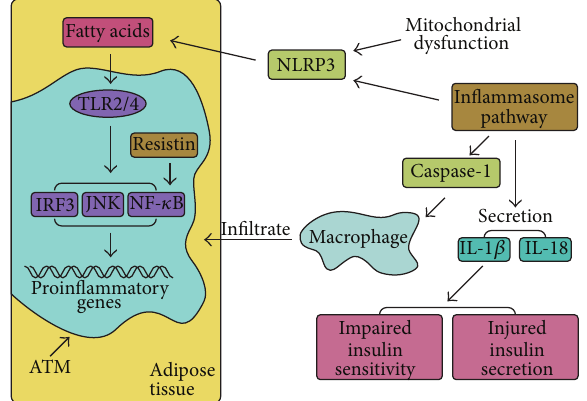
Figure 3: Inflammasome pathway and macrophages are involved in development of insulin resistance. The secretion of IL- 𝛽 and IL-18 canberegulatedbyinflammasomepathway.Inflammasomeconsists ofalargegroupofcytosolicproteincomplexesincludingNLRP3and caspase-1. NLRP3 can be activated by mitochondrial dysfunction through causing ROS accumulation, and NLRP3 is also a novel molecular link between saturated FFA and chronic inflammation. Caspase-1 mediates macrophages that infiltrate into adipose tissues. Dietary saturated fatty acids lead to activation of TLR2 and TLR4 in ATMs, giving rise to the activation of IRF3, JNK, and NF- 𝜅